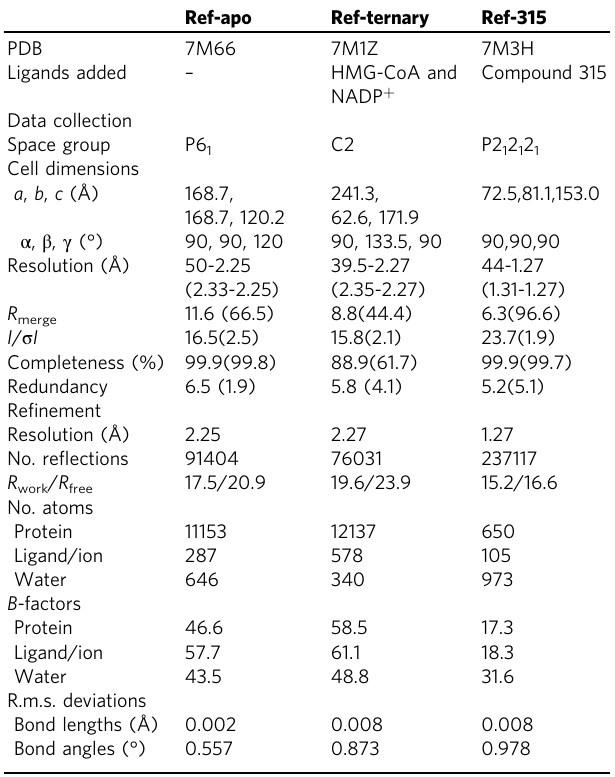
Table 1 Data collection and re fi nement